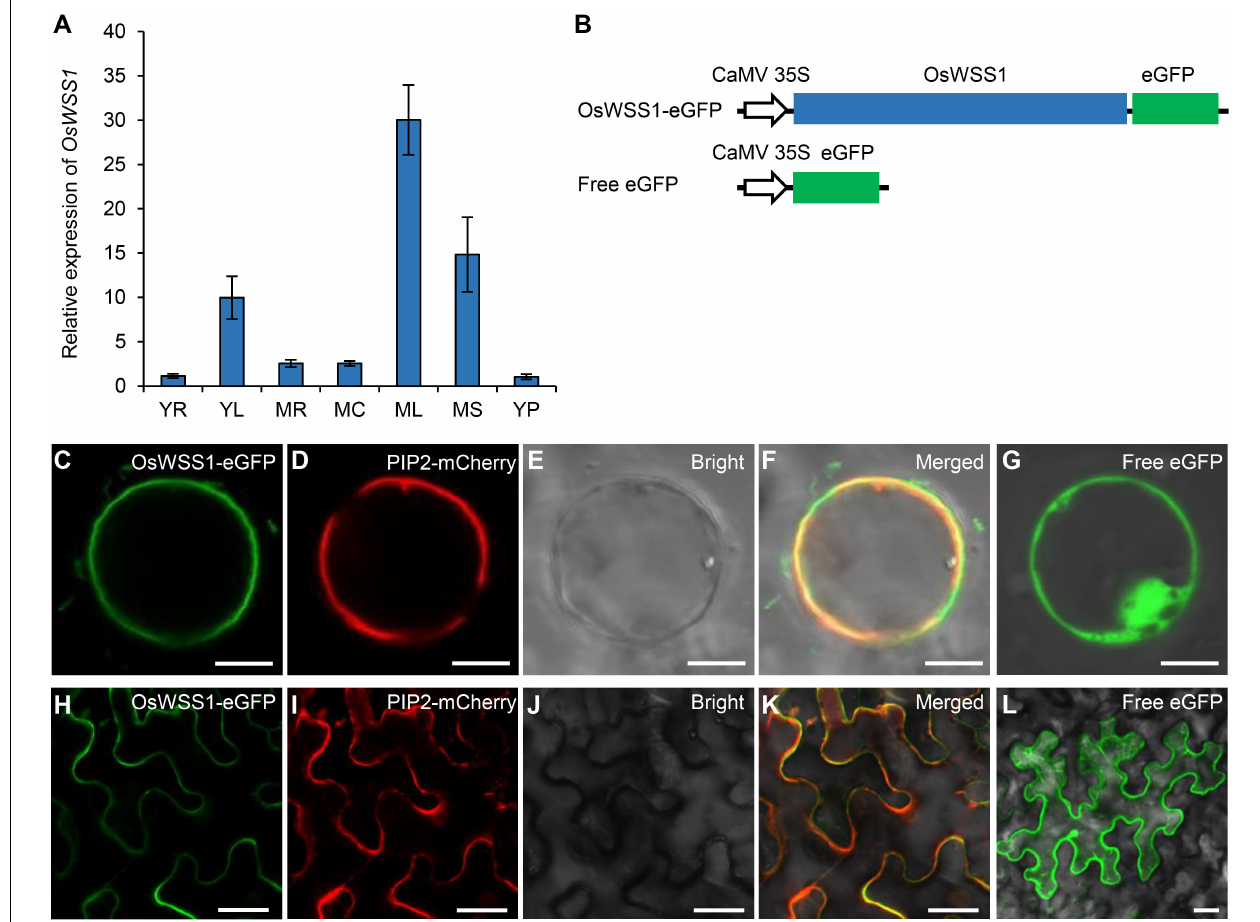
FIGURE 6 | Expression pattern of OsWSS1 and subcellular localization of the OsWSS1-eGFP protein. (A) Expression pattern of OsWSS1 in different tissues of the wild type plants. YR, Young root; YL, young leaf; MR, mature root; MC, mature culm; ML, mature leaf; MS, mature sheath; YP, young panicle. OsWSS1 expression was normalized using the OsActin gene as an internal control. OsWSS1 expression of YR was normalized to 1 after the normalization with the value of OsActin . Values are mean ± SD ( n = 3). (B) A schematic diagram of the constructs used for subcellular localization. (C–F) Subcellular localization of OsWSS1 in rice protoplast. The fusion protein (OsWSS1-eGFP) (C) was co-expressed with the plasma membrane marker (PIP2-mCherry) (D) . (G) Subcellular localization of the control (Free-eGFP) in rice protoplast. (H–K) Subcellular localization of OsWSS1 in epidermal cell of Nicotiana benthamiana leaves. The fusion protein (OsWSS1-eGFP) (H) was co-expressed with the plasma membrane marker (PIP2.1-mCherry) (I) . (L) Subcellular localization of the control (Free-eGFP) epidermal cell of N. benthamiana leaves. Scale bars: 5 µ m (C–G) ; 15 µ m (H–L)